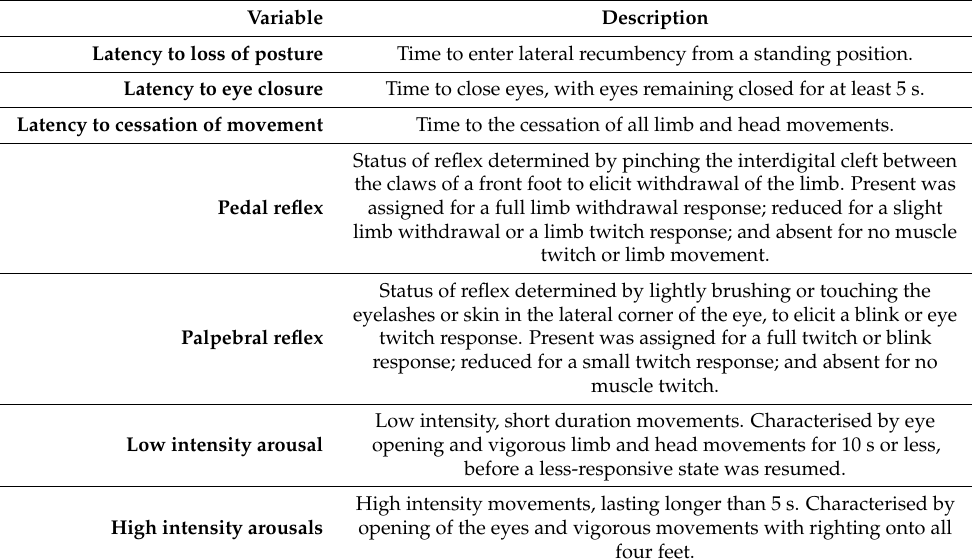
Table 2. Behavioural responses recorded during application and maintenance of the 10 min thoracic squeeze. Variable Description